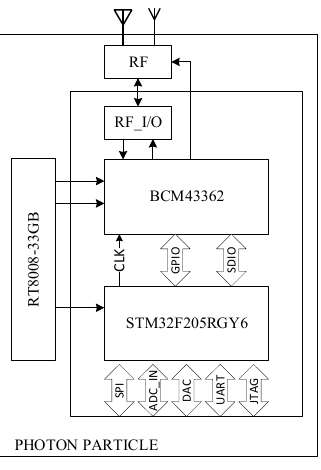
Figure 4. The Photon Particle detailed elements.